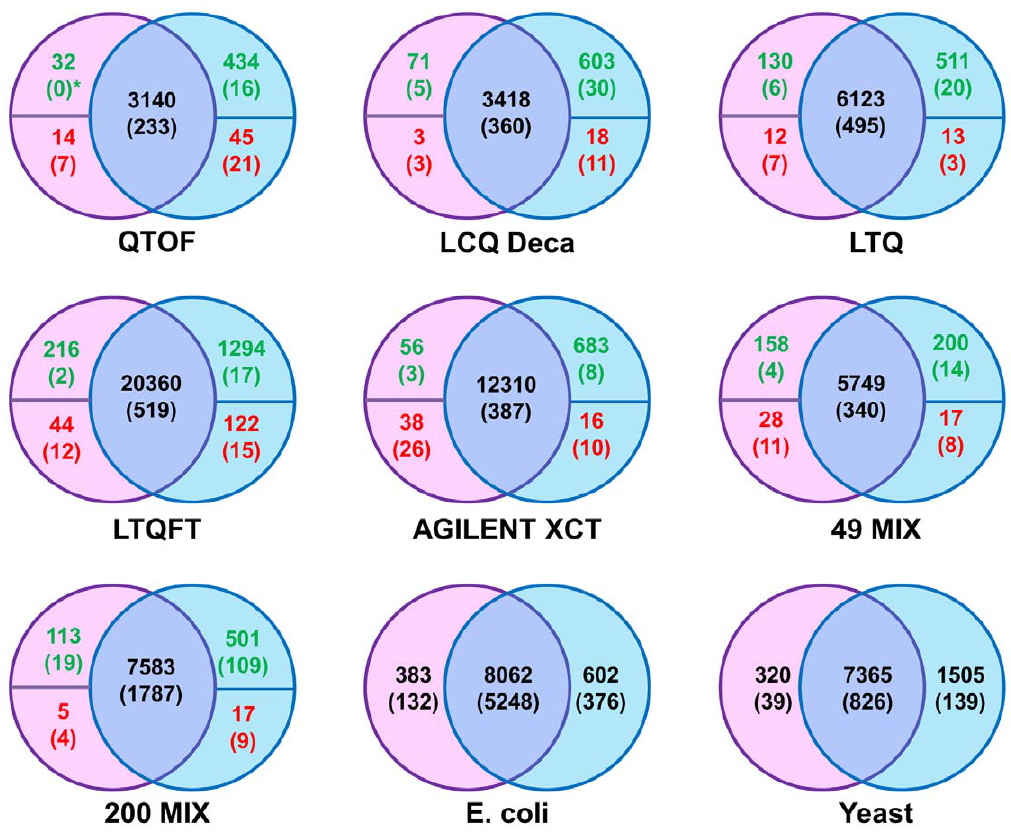
Figure 3. Comparison of spectra and peptides assigned by FDR and FlexiFDR for concatenated search. Comparison of spectra and peptides assigned by FDR (pink) and FlexiFDR (blue) for concatenated database search. The number of spectra is shown on top with the number peptides in brackets beneath them. For the standard mixtures, the true positives (green) and false positives (red) identified exclusively are highlighted. FlexiFDR identifies a higher number of true unique spectra and peptides than FDR in almost all cases. The proportion of false positives in exclusively identified set is higher in FDR than FlexiFDR. A star symbol (*) depicts that although there are non-zero true positive spectra identifications in few cases of FDR, they could not bring in any new peptide identification. The peptides they identified were already identified by other spectra (which are shared by both FDR and FlexiFDR).